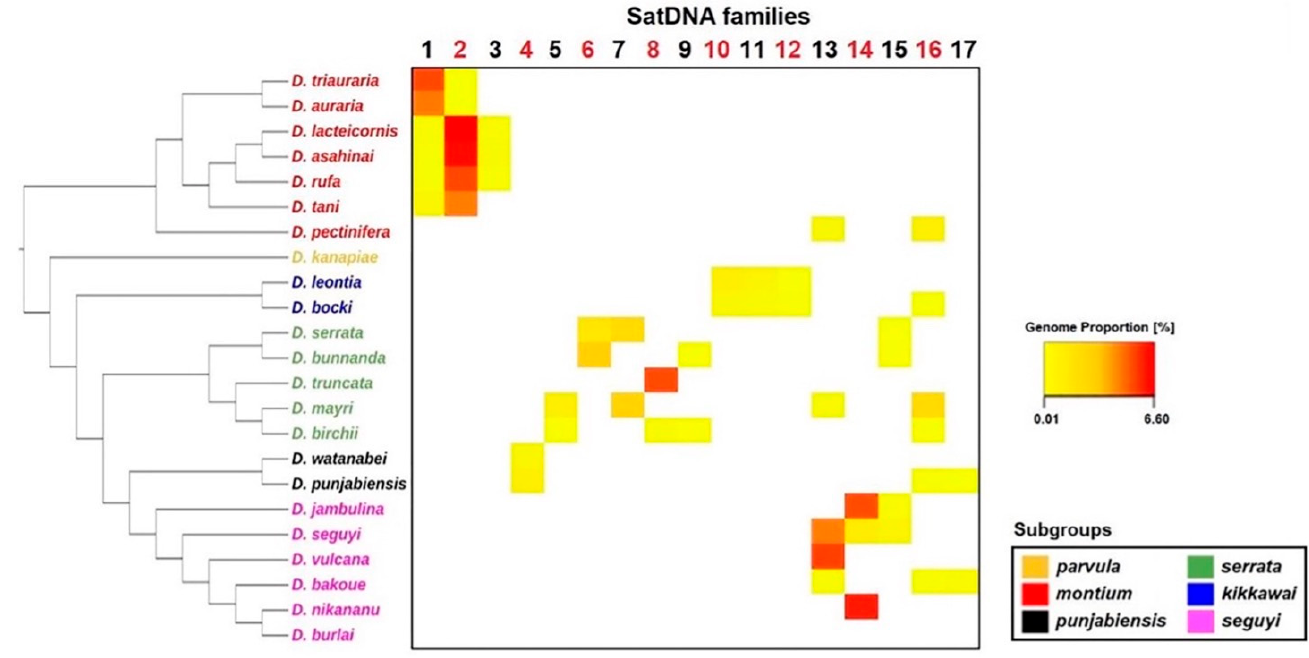
Figure 7. Heatmap showing the genomic proportion for each satDNA family shared by at least two species. The phylogenetic tree was reconstructed according to Conner et al. [30] using the Archaeopteryx software [31]. Species names are colored according to the subgroups they belong to (see Figure 1). The genomic proportion values for each satDNA are described in Table S1.